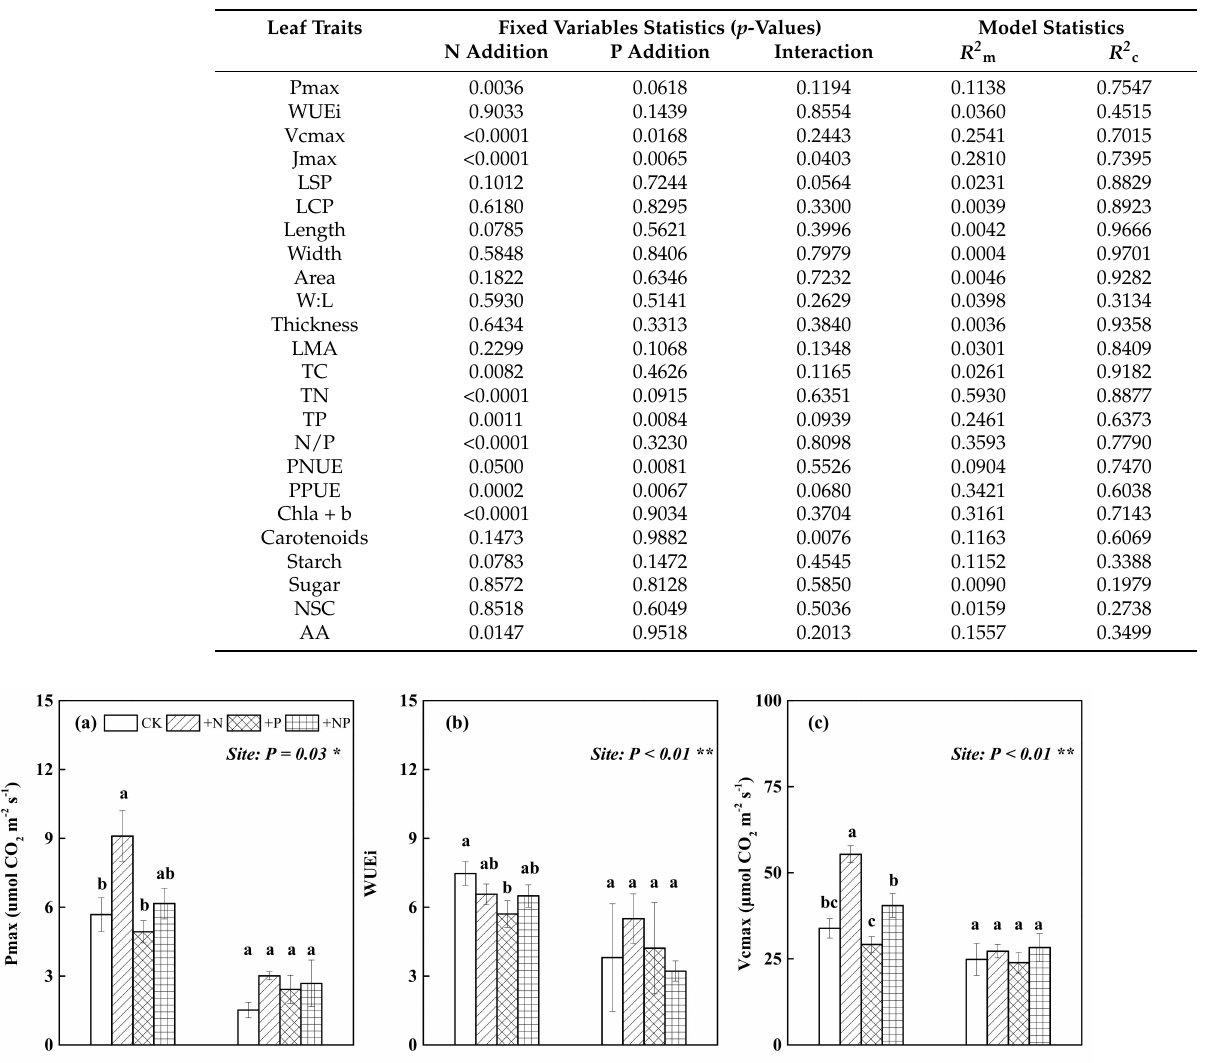
under field and pot experimental nitrogen and phosphorus addition. Note: R 2 c = Percentage of